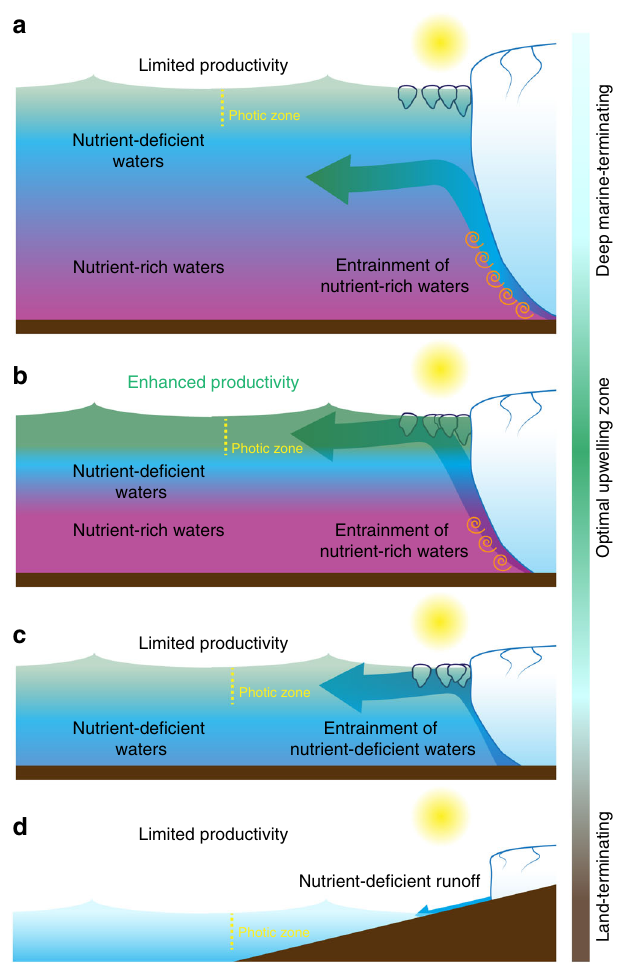
Fig. 3 Schematic of possible macronutrient upwelling scenarios for idealized marine-terminating glacier systems. a Deeply grounded glaciers result in plumes that lose buoyancy through entrainment and equilibrate below the photic zone. b Glaciers grounded within the optimum zone for nutrient upwelling facilitate equilibration of a macronutrient-rich plume in the photic zone. c Plumes emerging from shallow glaciers equilibrate in the photic zone; however, they are unable to entrain deep, nutrient-rich